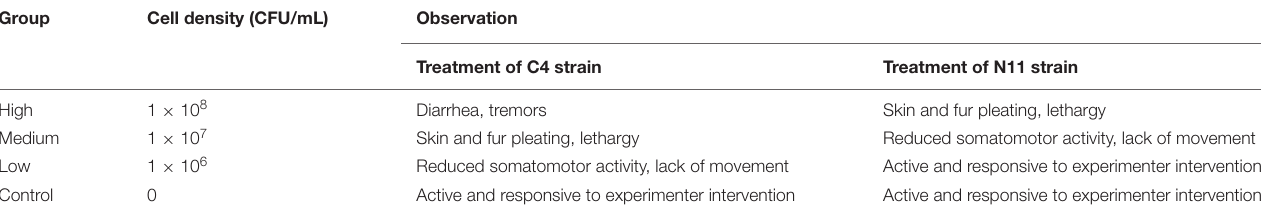
TABLE 1 | Observations of mice after oral gavage with Vibrio parahaemolyticus . Group Cell density (CFU/mL) Observation Treatment of C4 strain Treatment of N11 strain Diarrhea, tremors Skin and fur pleating, lethargy Skin and fur pleating,